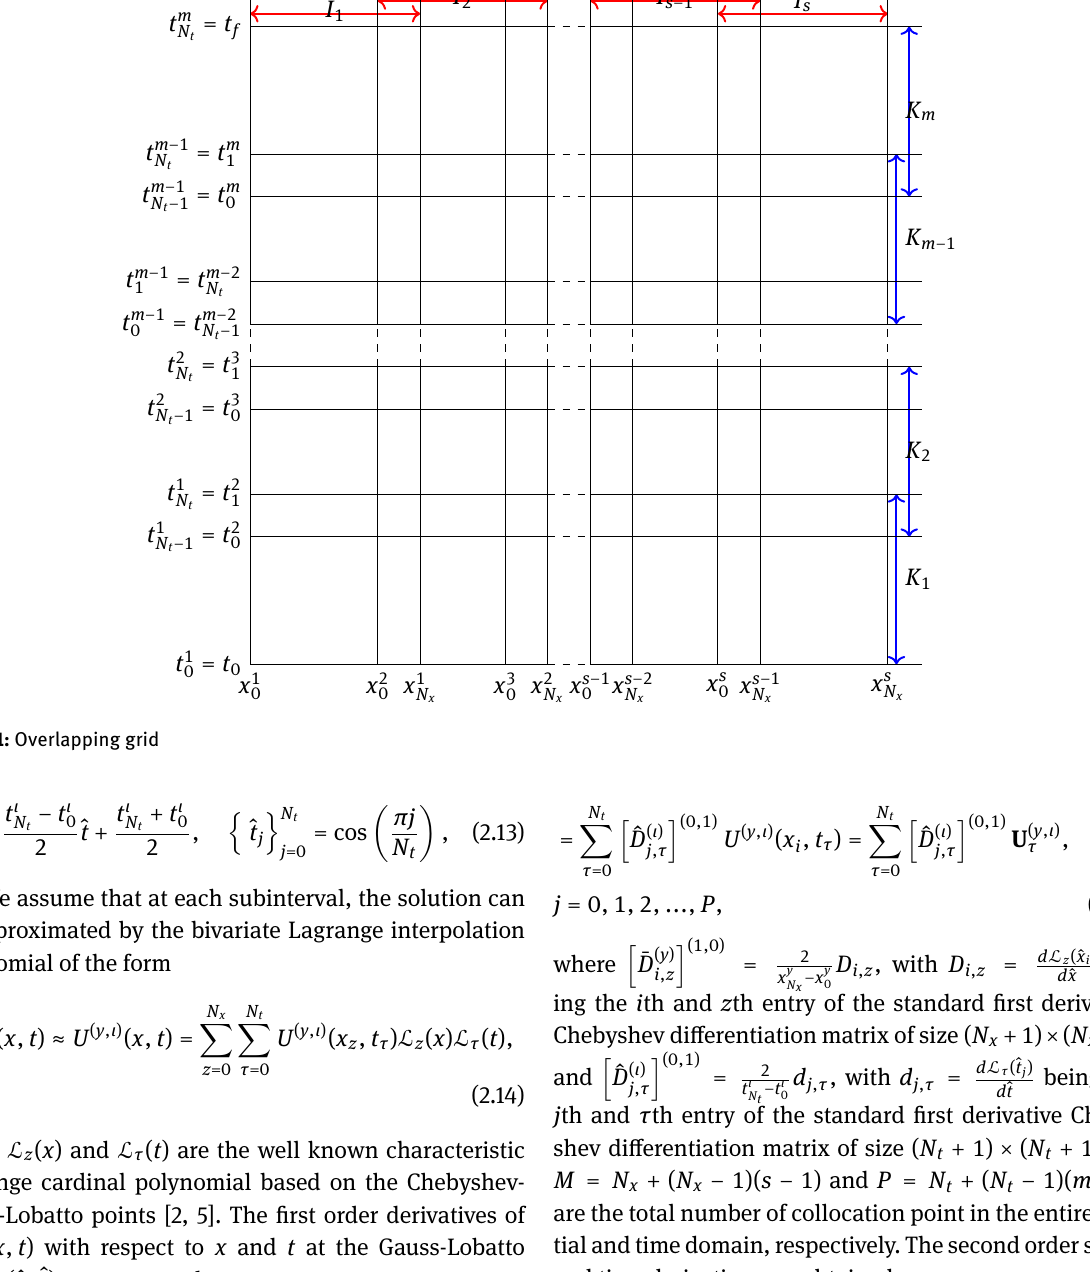
Figure 1: Overlapping